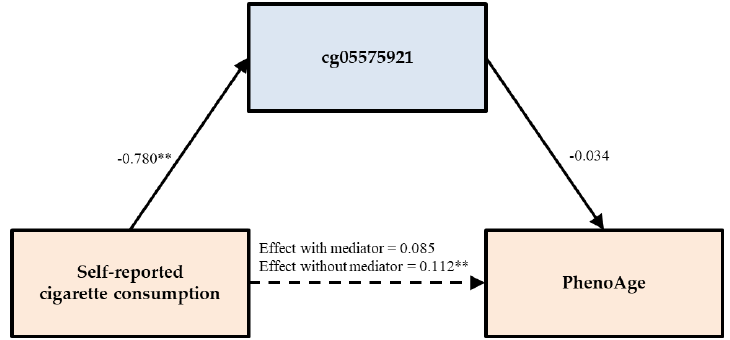
Figure 2. cg05575921 reduces the direct effect of self-reported cigarette consumption on PhenoAge to non-significance. Note. Chi-square = 41.539, df = 7, p = 0.000; CFI = 0.944; SRMR = 0.041. Values are standardized parameter estimates. ** p ≤ 0.01; * p ≤ 0.05 (two-tailed tests).